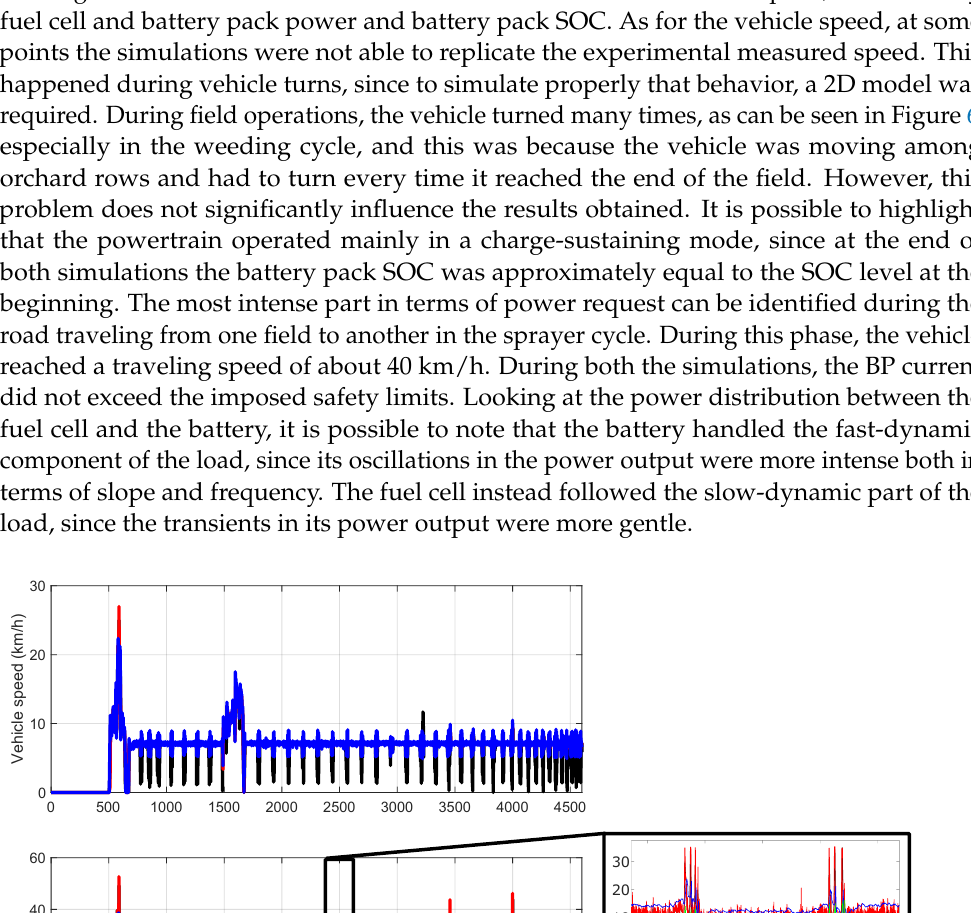
Figure 16. Simulation results for the sprayer work cycle.